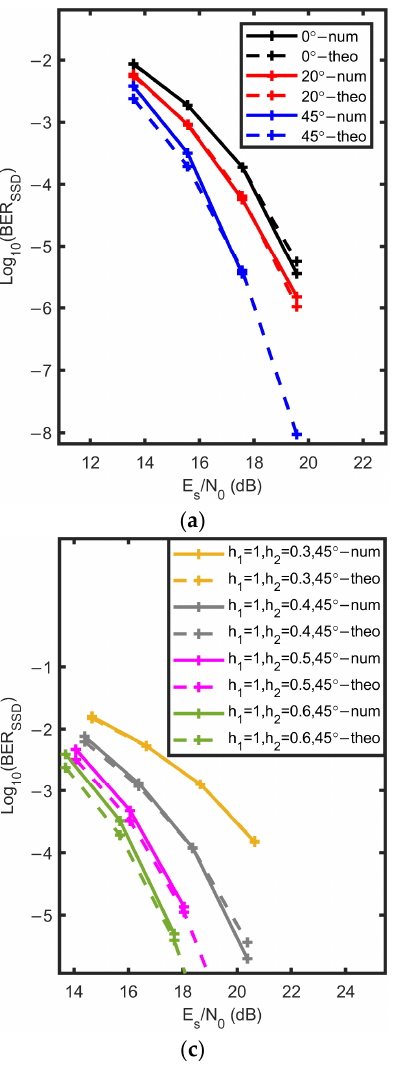
Figure 4. BER of the SSD scheme. ( a ) With different ϕ . ( b ) With different channel gains and different ϕ . ( c ) With d 1 = d 2 at ϕ = 45 ◦ . ( d ) With d 1 ∼ = d 3 . Note: num—numerical, theo—theoretical. Table 1. The values of d 1 , d 2 , and d 3 with different channel gain distributions at different ϕ